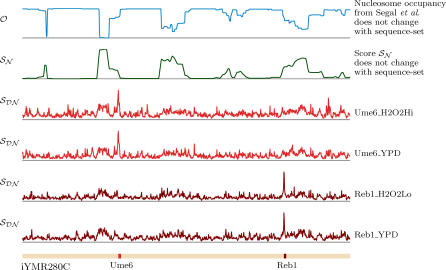
S℘D℘
N℘ over a Single Sequence Belonging to Multiple Sequence-SetsThe intergenic region iYMR280C belongs to four sequence-sets: Ume6_H2O2Hi, Ume6_YPD, Reb1_H2O2Lo, and Reb1_YPD. The boxes indicate binding sites annotated by Harbison et al. [2]. S℘D℘
N℘ for each sequence-set is different although S℘N℘ does not change. S℘D℘
N℘ indicates correctly the location of the binding site of the respective TF.